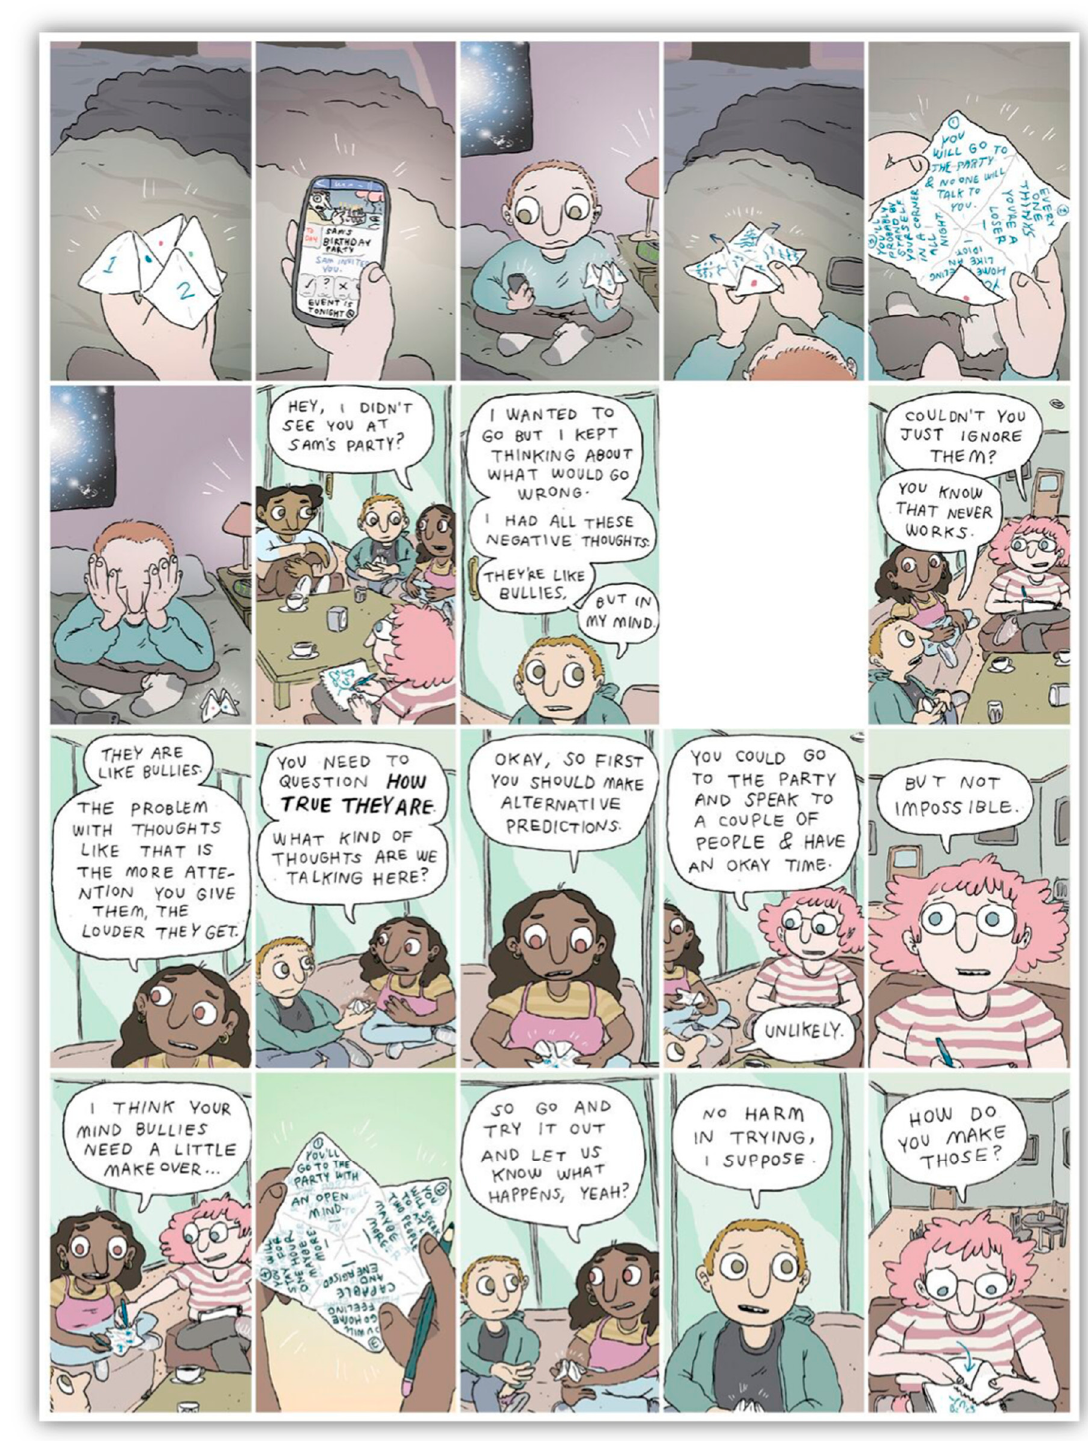
Figure 1. Example of a Graphic-Medicine Style Comic Used in the Entourage Platform.